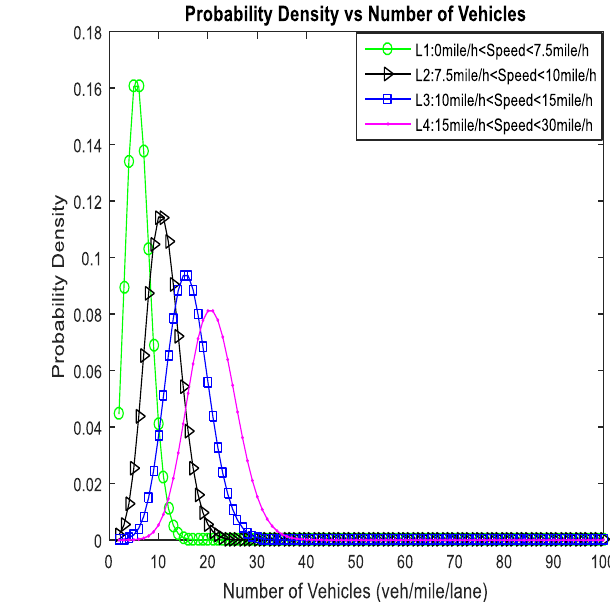
Figure 7. The effect of traffic flow when λ =5 Figure 8. The effect of traffic flow when λ =6